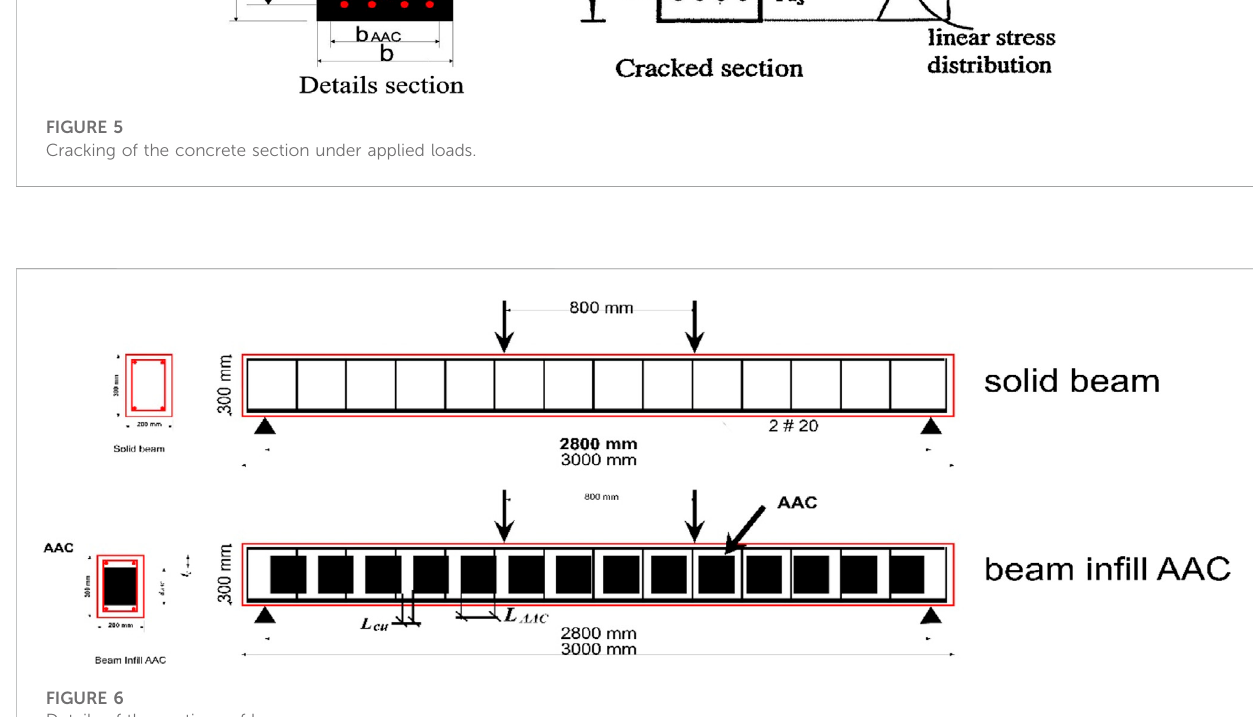
Details of the sections of